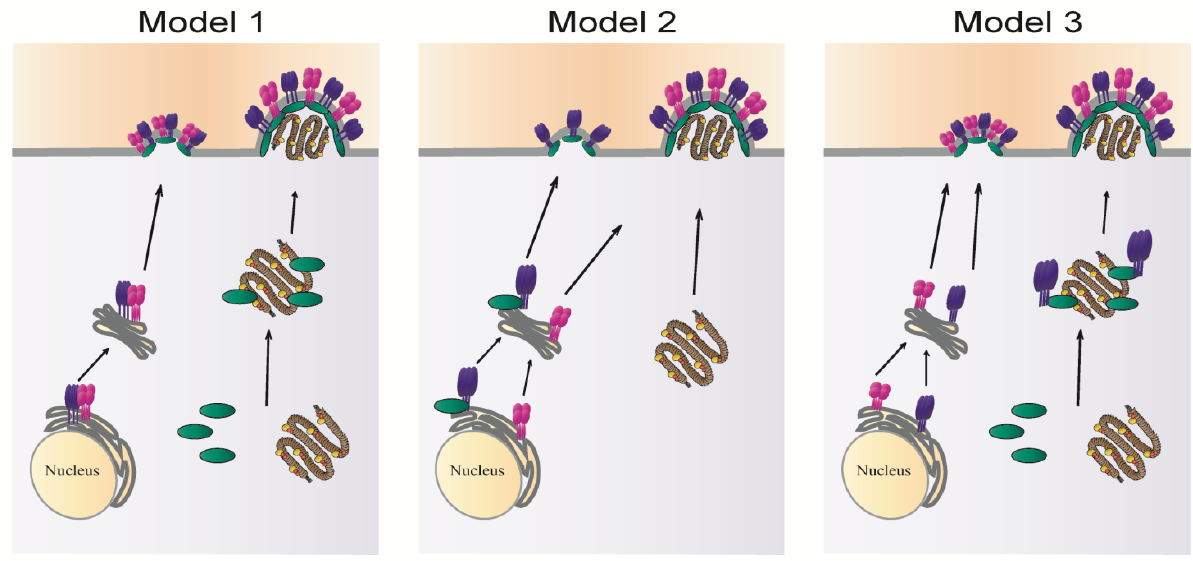
Figure 4. Potential models of paramyxovirus assembly: fusion protein shown in purple, attachment protein in magenta, matrix protein in green and the RNP complex in